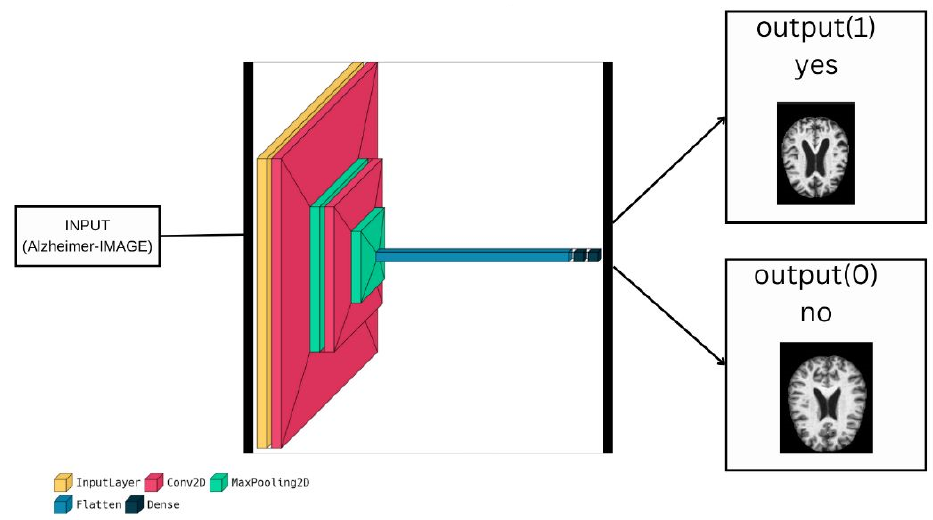
Figure 4. Model visualization to binary classification task.